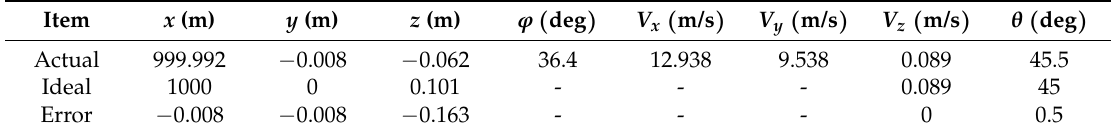
Table 5. Terminal states corresponding to case 3.